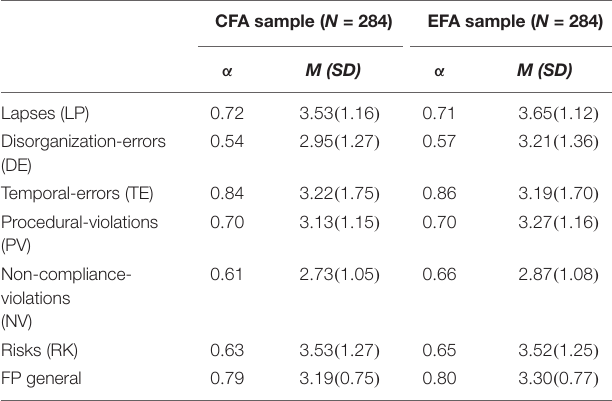
TABLE 1 | Cronbach’s α Reliabilities, means and standard deviations of FP scales – as obtained in the two samples in Study